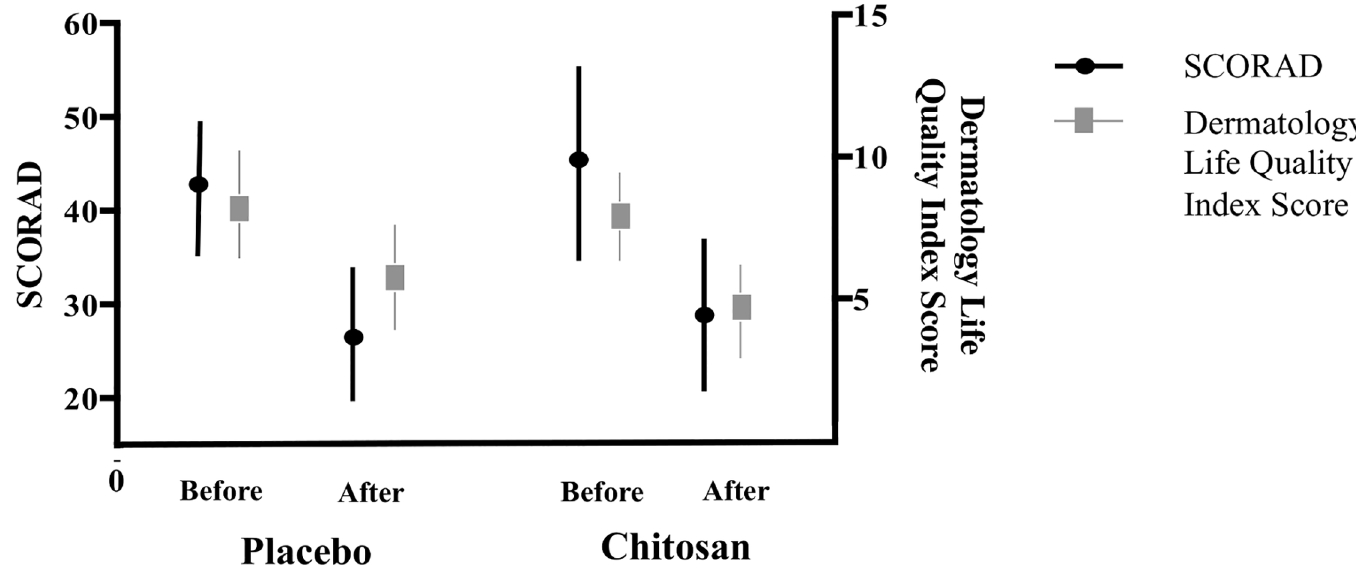
Fig 2. Mean SCORAD and Dermatology Life Quality Index scores (95% CI) in chitosan and placebo groups before and after intervention. CI- confidence interval.